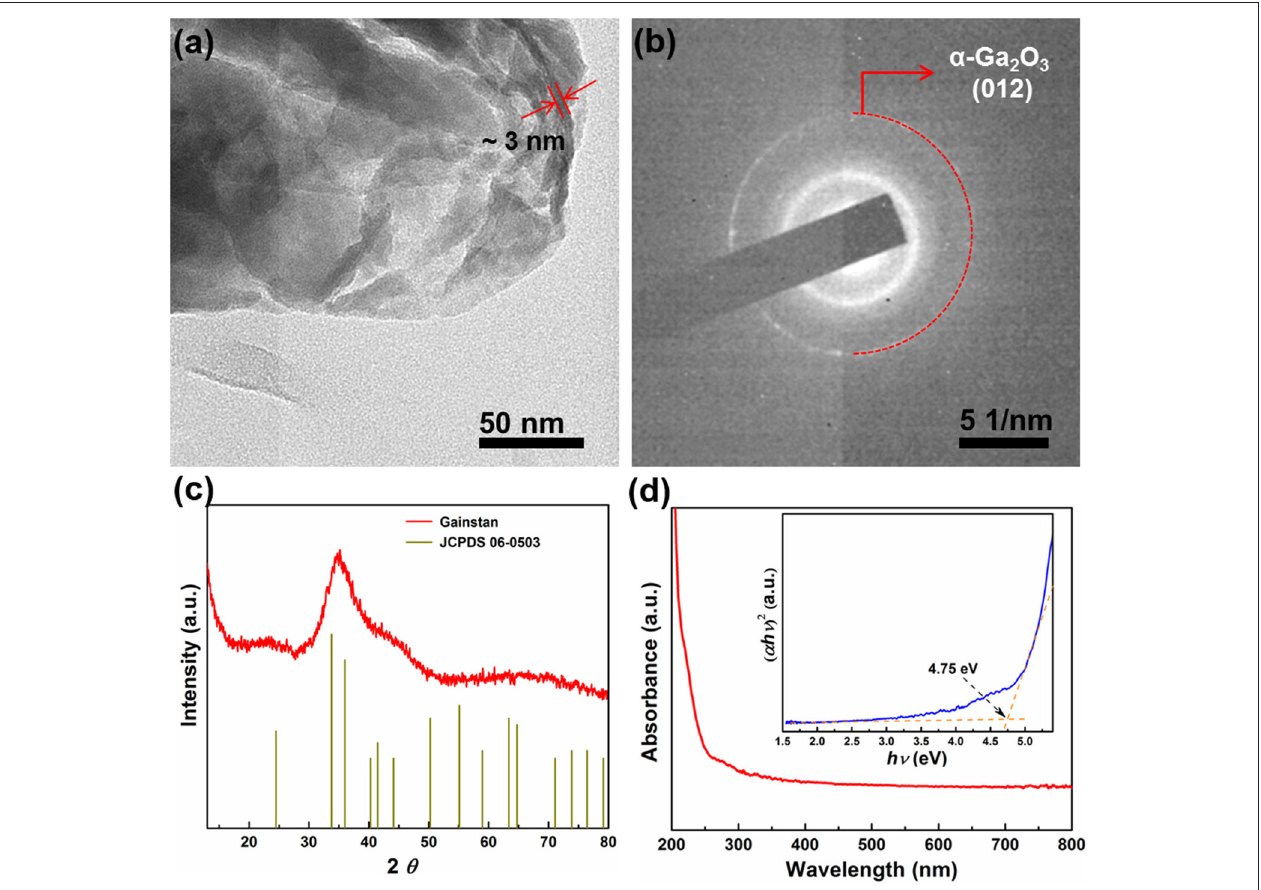
FIGURE 2 | (a) TEM image and (b) SAED pattern of the native Ga-oxide nanosheets. (c) XRD pattern of the galinstan electrode. (d) The absorption spectrum of the native Ga-oxide nanosheets, the inset is ( α h ν ) 2 vs. h ν .